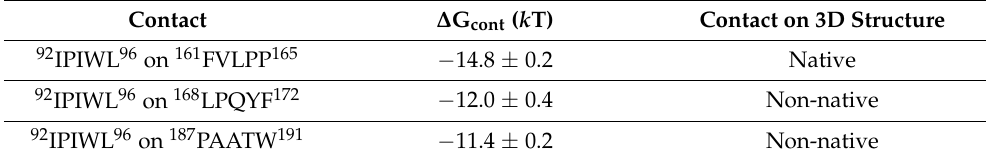
Table 1. Predicted possible primary contacts for VP40. Error estimates are standard deviations [60]. The location on the structure of the defining segments was determined on the PDB structure 7JZT [61]. Contact ∆ G cont ( k T) Contact on 3D Structure 92 IPIWL 96 on 161 FVLPP